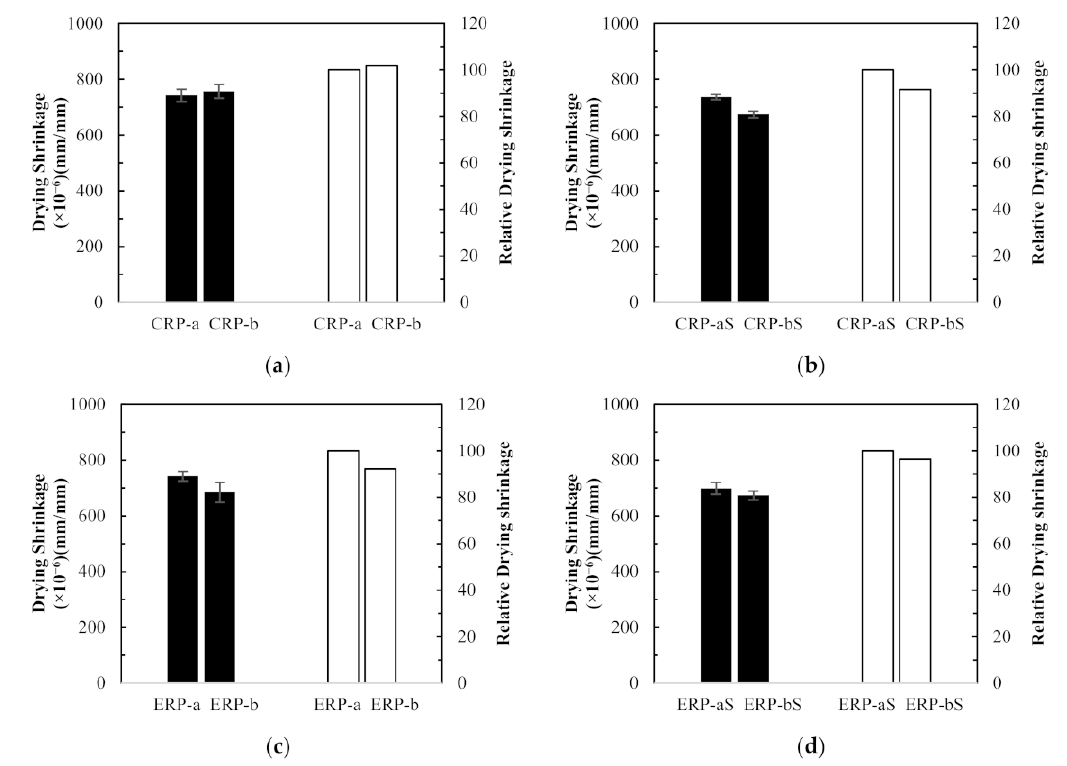
Figure 11. Concrete drying shrinkage results and relative values between different recycled concrete aggregate replacement ratios: ( a ) CRP-a versus CRP-b, ( b ) CRP-aS versus CRP-bS, ( c ) ERP-a versus ERP-b, and ( d ) ERP-aS versus ERP-bS.